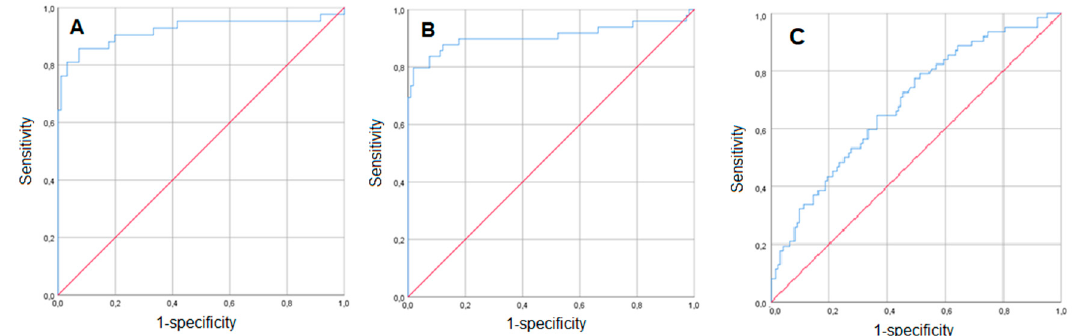
Figure 1. Prediction of placental abruption-ROC (Receiver Operating Characteristic) curves for the multivariate binary regression models presented in Table 2 (bleeding patients) ( A ), Table 3 (non-bleeding patients) ( B ), and Table 4 (patients with placental abruption) ( C ).